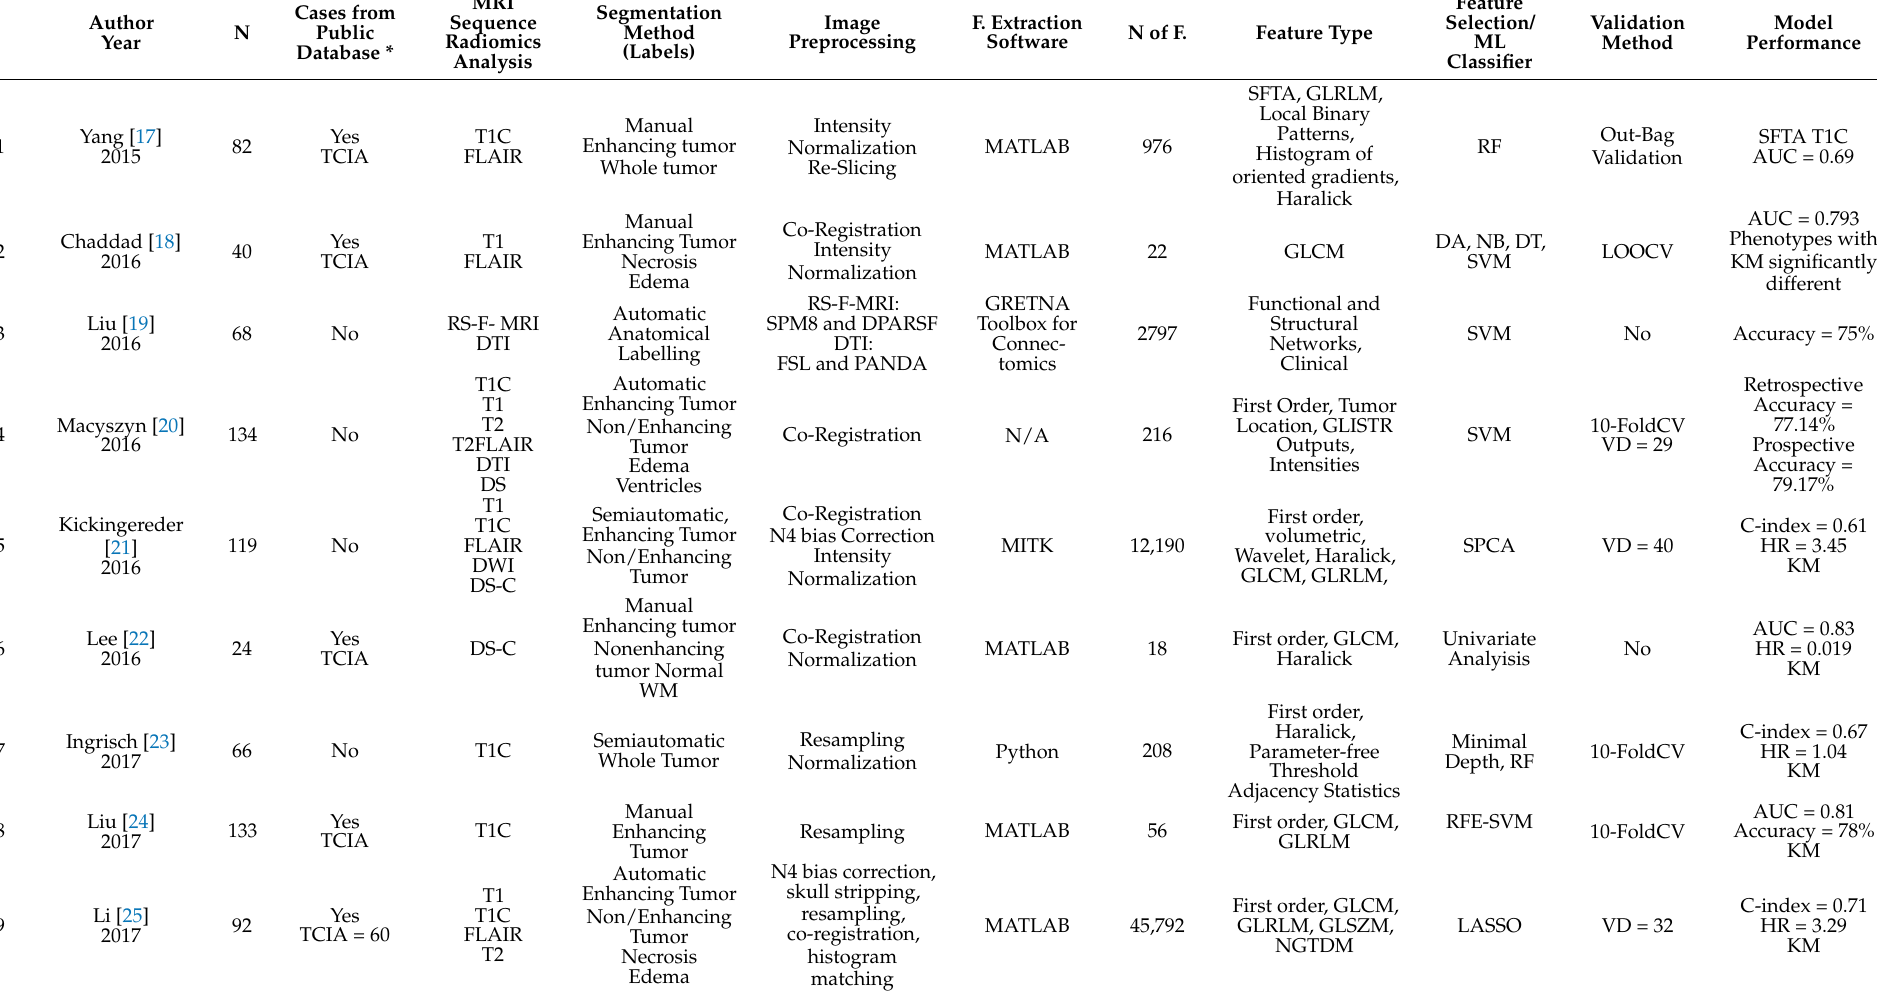
Table 1. Summary of the studies analyzed in this